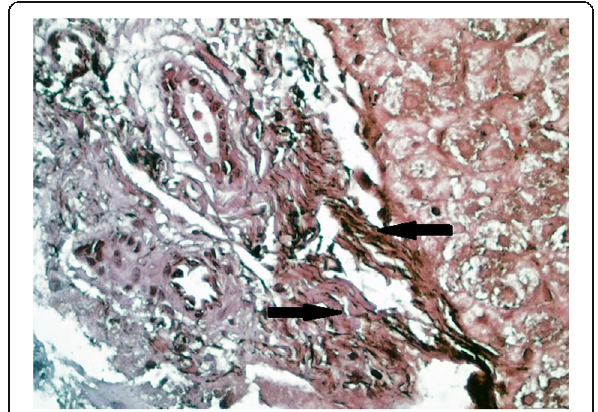
Fig. 1 Representative case of F4 fibrosis, stained with orcein, 400x magnification. Elastic fibers are thin structures (black arrows), surrounded by collagen (thicker and lighter